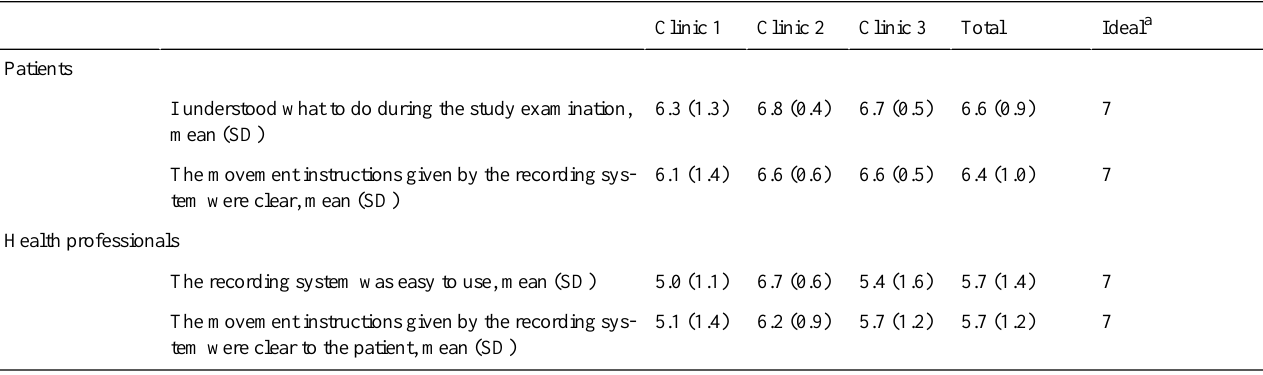
Table 5. Questionnaire data for effectiveness metric.